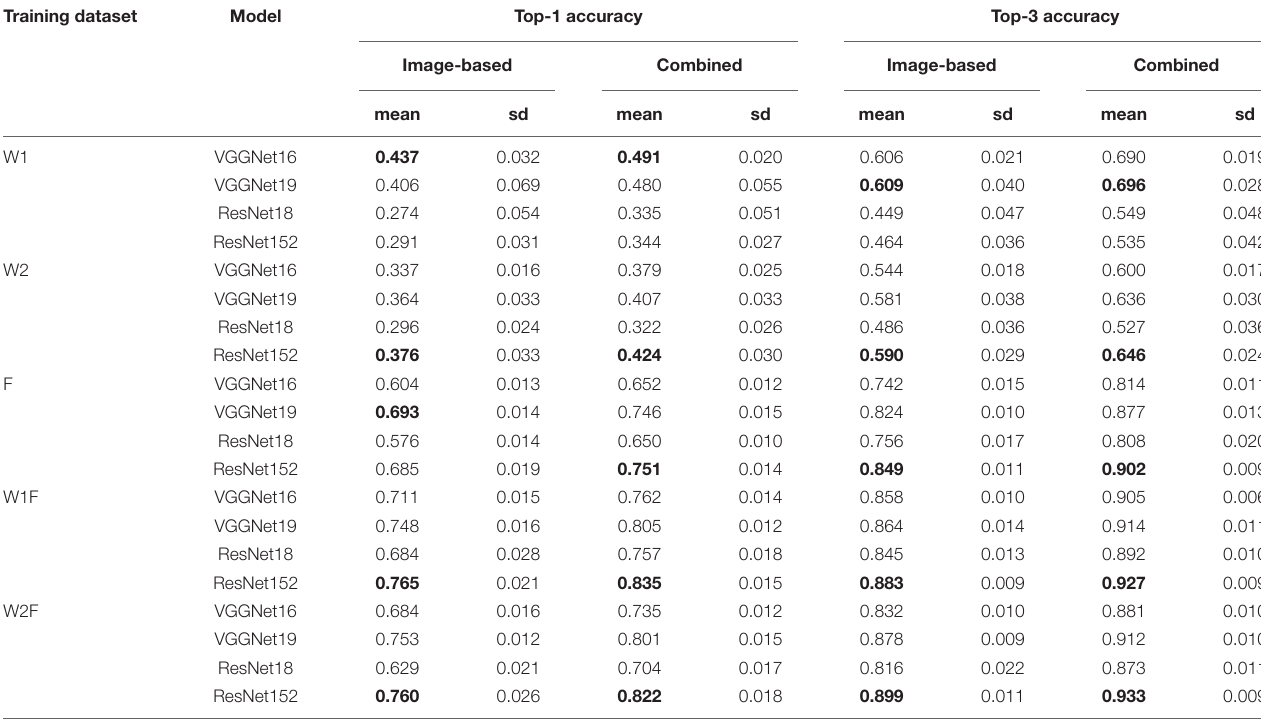
TABLE 3 | The top-1 and top-3 accuracies of image-based and combined models for genus identification. Training